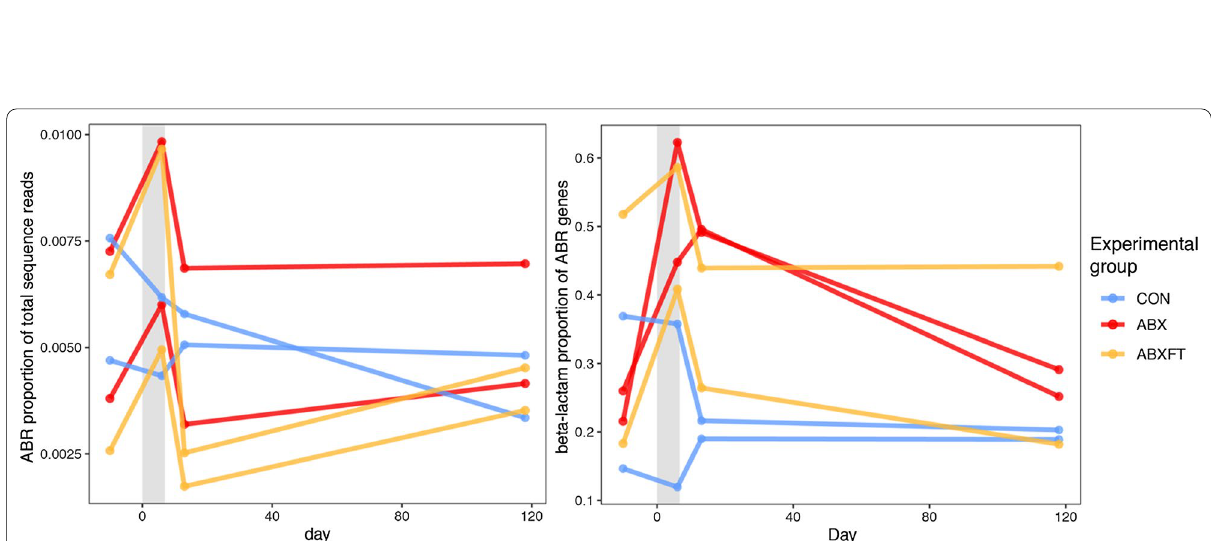
Fig. 8 Patterns in antibiotic resistance across healthy, male ring‑tailed lemurs ( Lemur catta ) that received no treatment (CON), antibiotics only (ABX), or antibiotics plus fecal transfaunation (ABXFT). Shown is variation over time in a the relative abundance of antibiotic resistance (ABR) genes and b the proportion of ABR genes assigned to the beta‑lactam resistance gene family. The gray shaded window represents the period of antibiotic treatment, with the prior period representing baseline and the subsequent period representing recovery. SEM